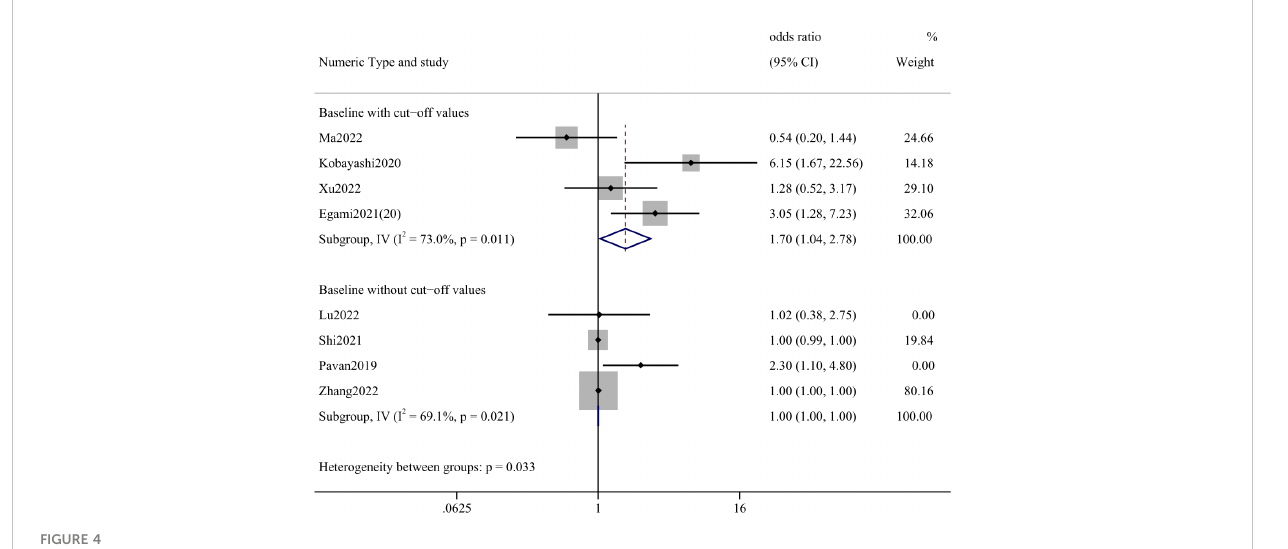
FIGURE 4 Forest plot of correlation between PLR and incidence of